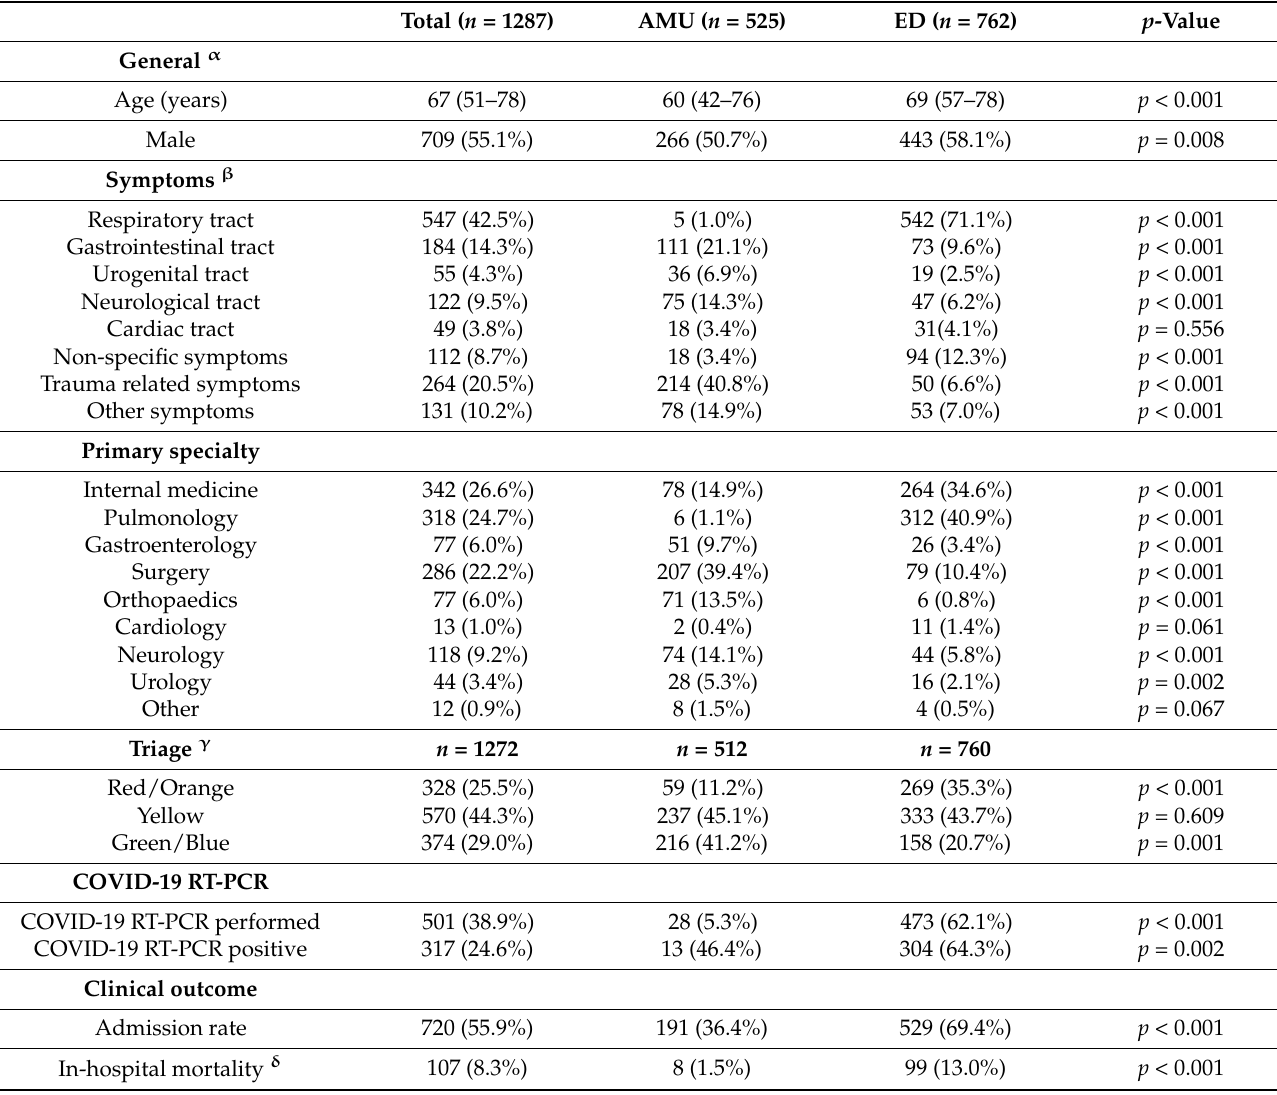
Table 1. Baseline characteristics of patients allocated to AMU or